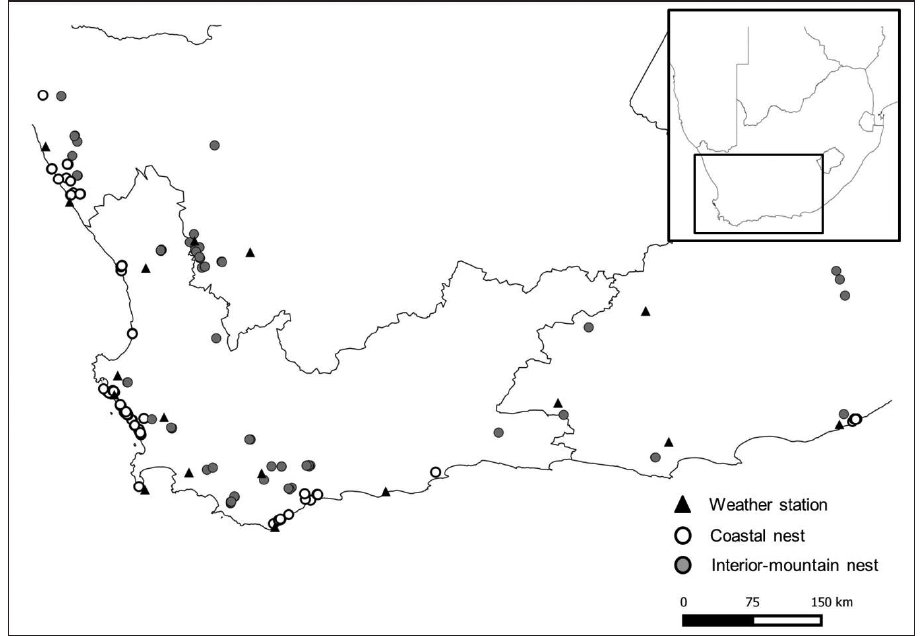
Figure 1. Location of study nests within South Africa for which weather data were available (n = 475), during 2000–2014. White circles: coastal nests; dark grey circles: interior-mountain nests; black triangles: weather stations that provided data for the purpose of the